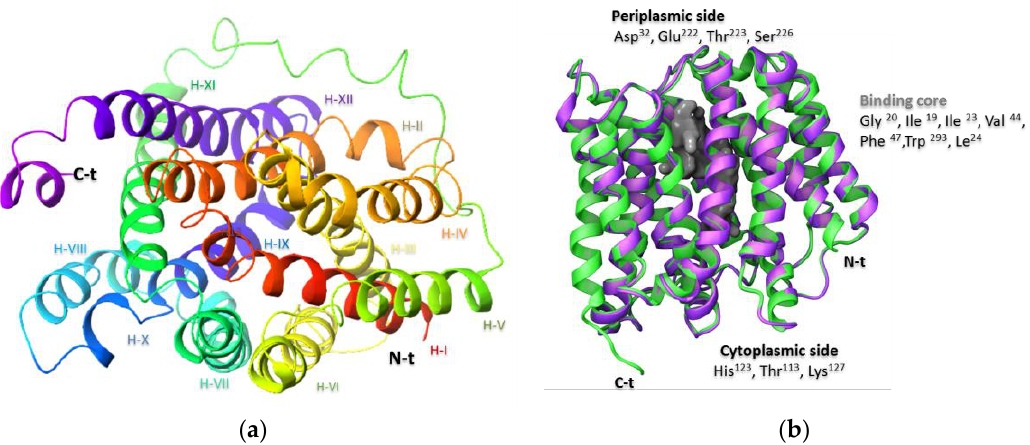
Figure 1. ( a ) 3D model structure of the NorA efflux pump from S. aureus , showing that both the N- and C-terminal domains are connected by XII α -helices and cytoplasmic loops. ( b ) Superposition of the 3D structure of the MFS proteins NorA (purple) and EmrD (green). The ligand binding core is highlighted in purple.